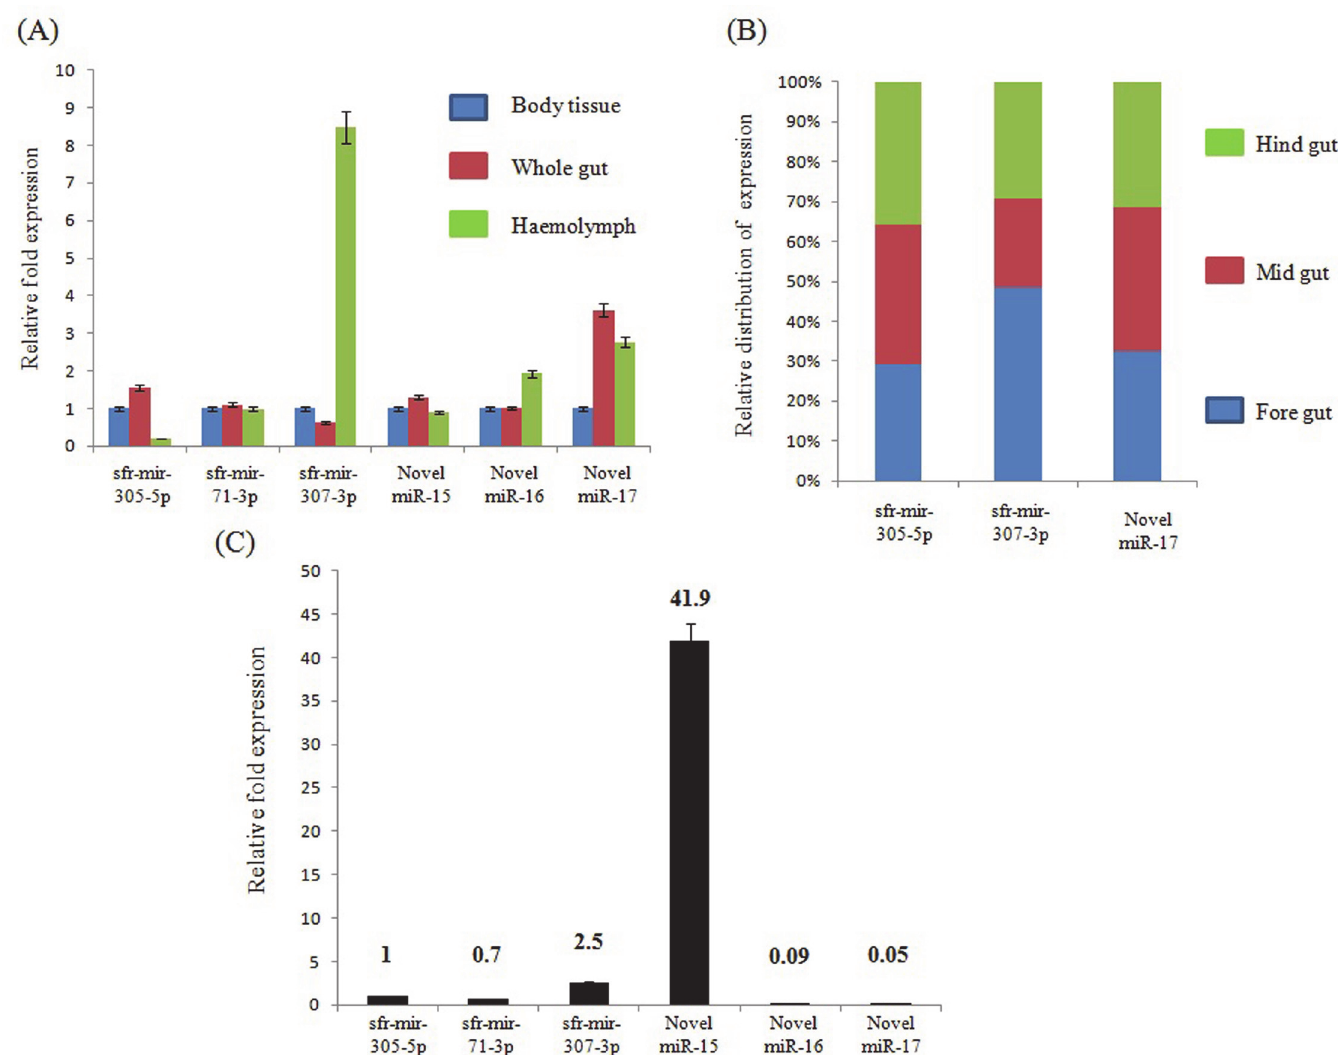
Fig 6. Tissue distribution of selected miRNAs in S. litura . The absolute expression levels of the selected miRNAs with respect to U6snRNA (endogenous control) were analyzed by TaqMan miRNA assays using total RNA isolated from respective tissue parts of the larvae. The bar graphs (A, C) represent the expression level of each miRNA in a particular tissue part but in comparison to that of miR-305-5p. (B) The bar graph represents the relative distribution of expression levels of each miRNA in three segments of the whole gut, i.e., fore gut, mid gut and hind gut. The statistical significance of the qRT analysis was determined by P value < 0.05 while the error bars represent the